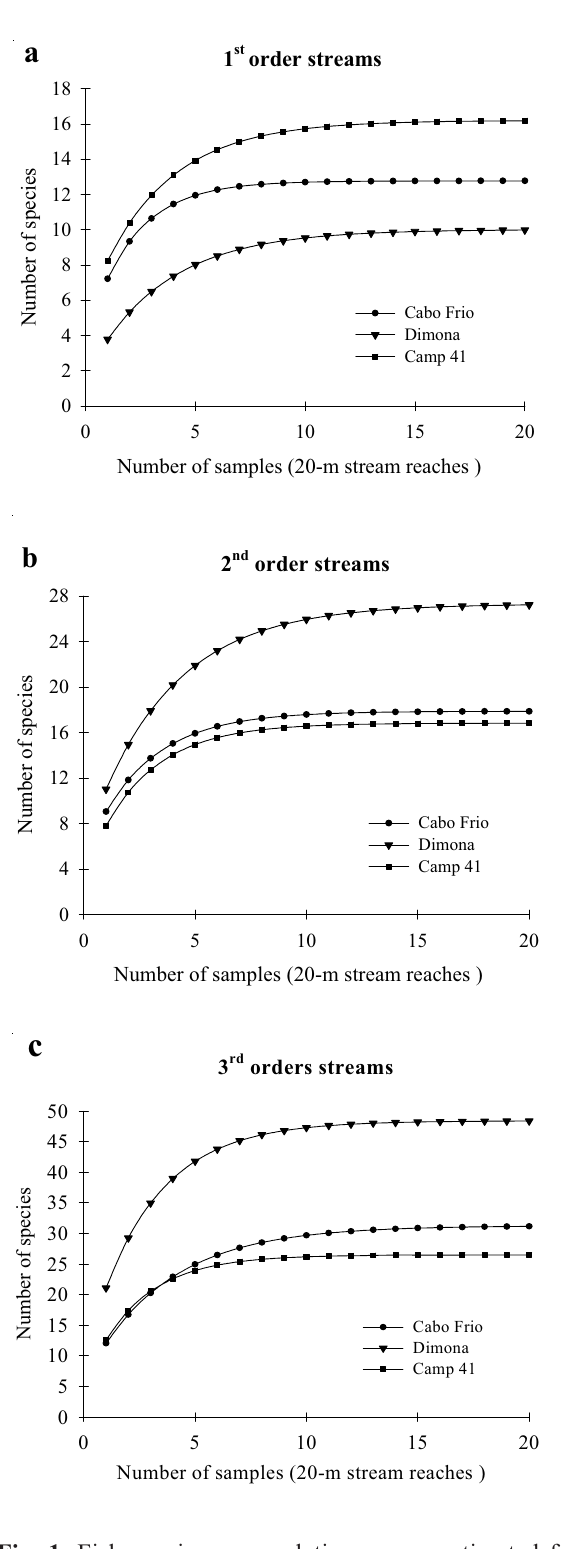
Fig. 1. Fish species accumulation curves estimated from samples obtained in 1 st , 2 nd , and 3 rd order streams reaches lo- cated in the study areas of Biological Dynamics of Forest Fragments Project, Manaus, Amazonas State. The curves rep- resent extrapolations from five reaches sampled in each stream segment.